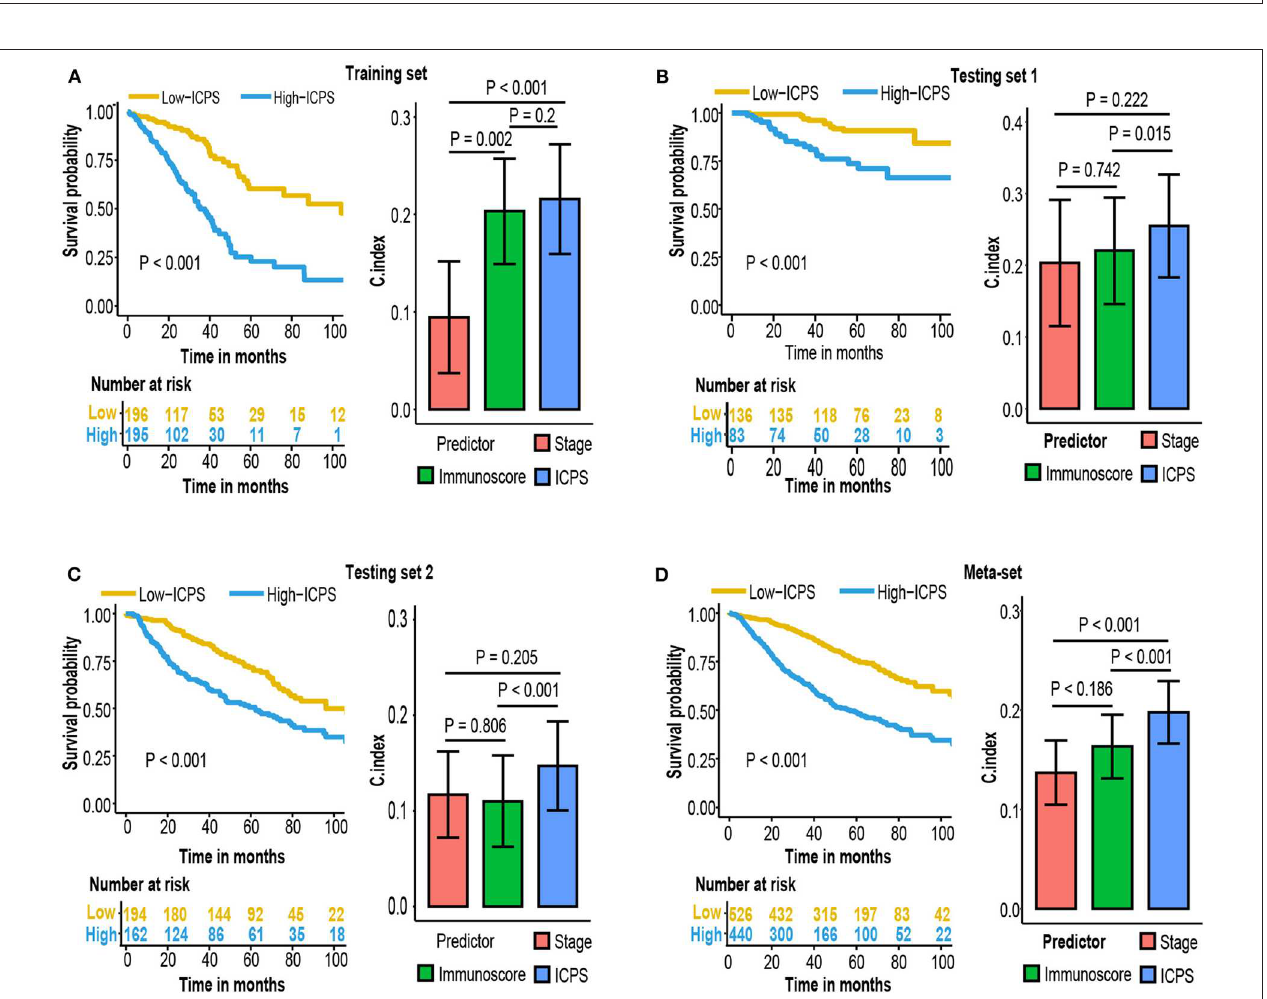
Frontiers in Oncology |